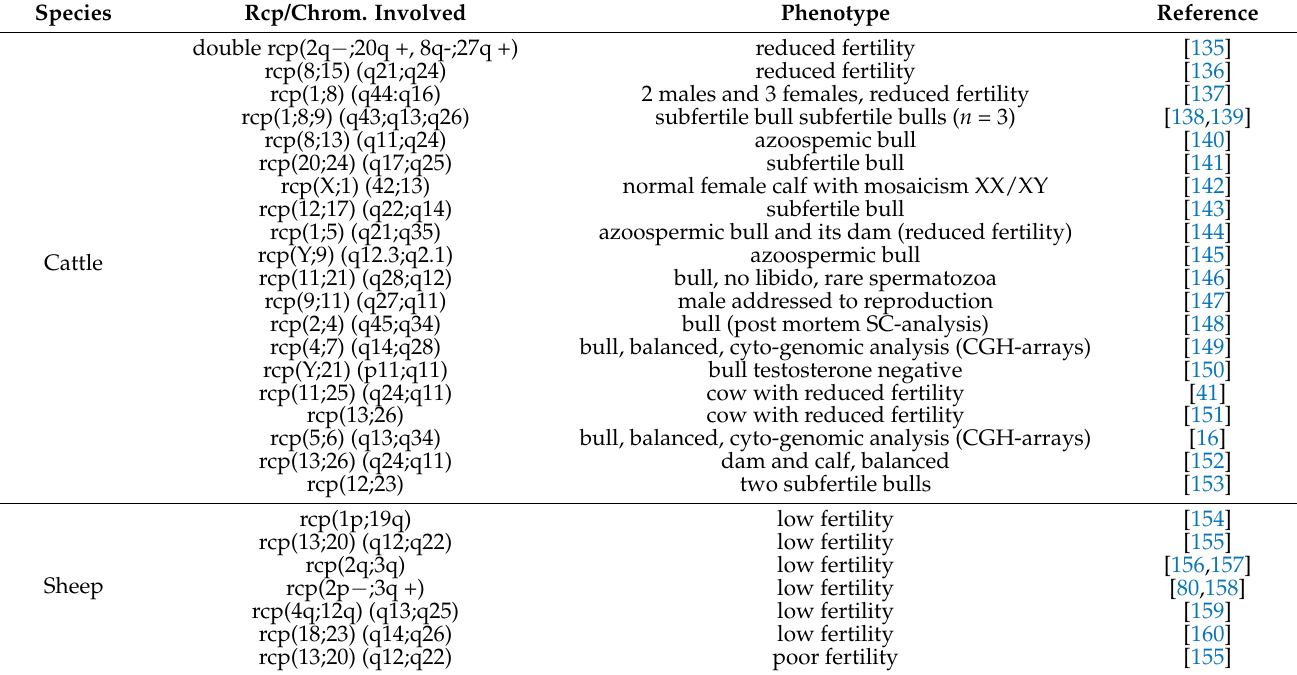
Table 7. Reciprocal translocations (rcp) found in cattle and sheep, with the chromosomes involved, phenotypic effects (when available), and author